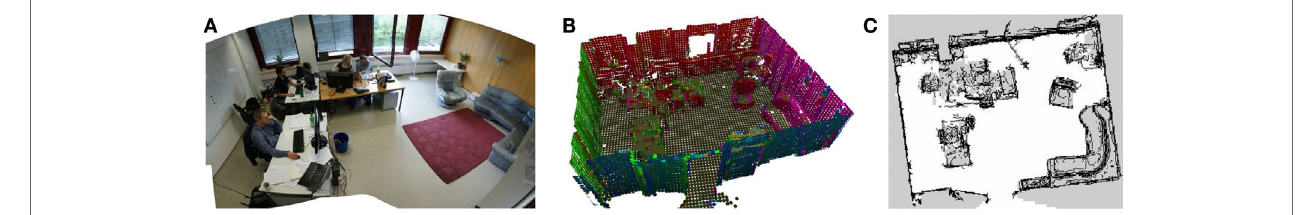
FIgURe 5 | 3D Surfel grid maps for navigation (Kläss et al., 2012) . (A) Panorama image of an office. (B) 3D surfel map learned with our approach (surfel orientation coded by color). (c) Navigation map derived from 3D surfel